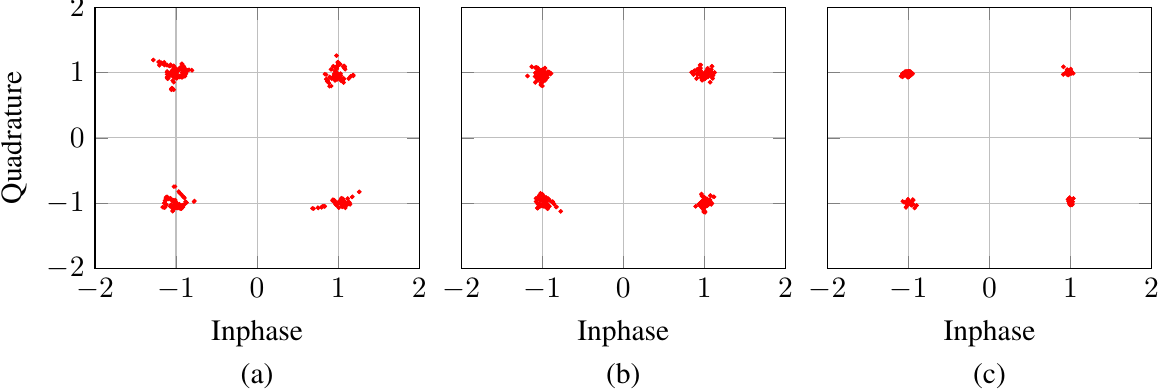
Figure 4. Received constellations after neural network processing for ( a ) mean square error (MSE) loss w/Split Complex, ( b ) MSE loss w/Concatenated Complex, ( c ) EVM loss w/Concatenated Complex for spectrally efficient frequency division multiplexing (SEFDM) with α =